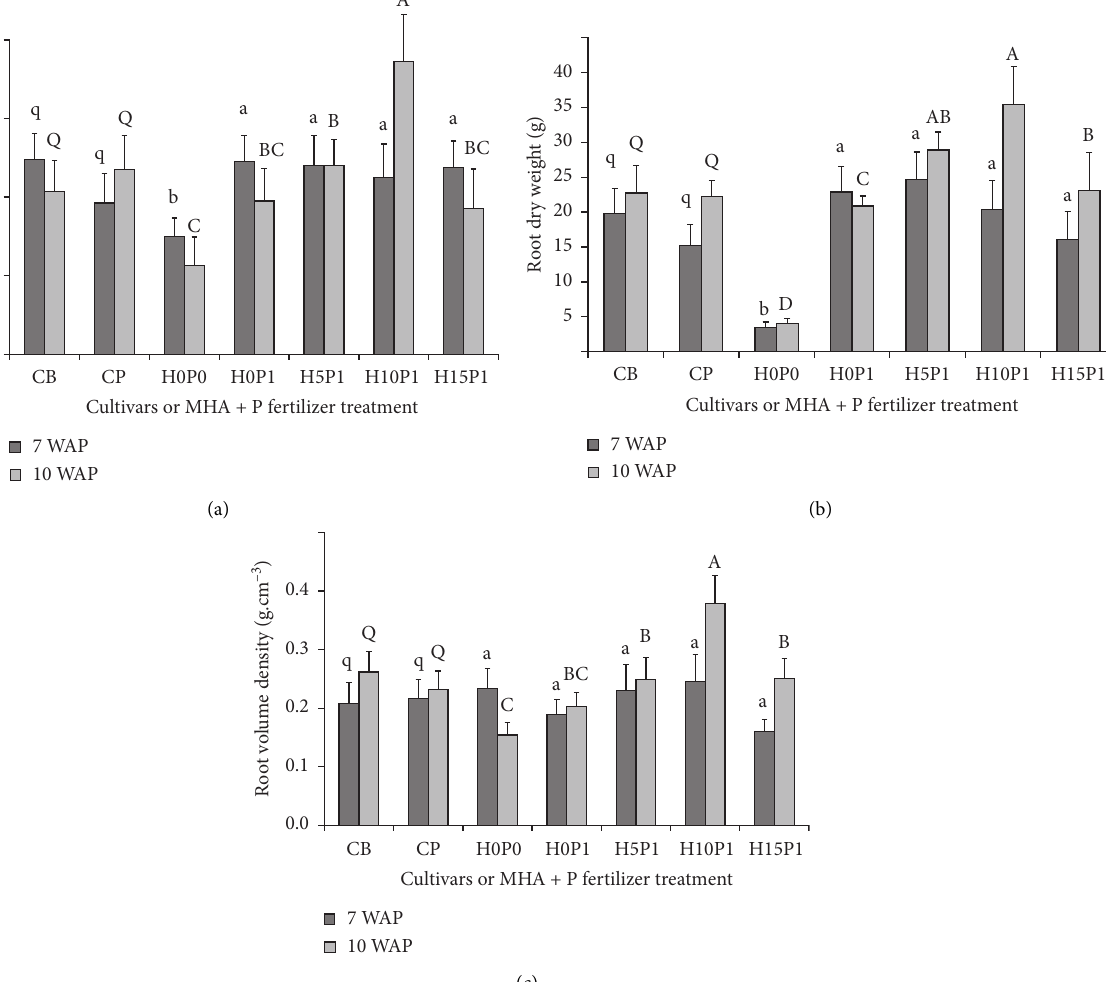
Figure 1: Root diameter (a), root dry weight (b), and root volume density (c) of corn 7 and 10 weeks after planting (WAP). CB is Bisi 2 hybrid corn, CP is Pioneer 35 hybrid corn. H 0 P 0 is the control, H 0 P 1 is 0 mg kg − 1 composted manure (MHA)+P fertilizer, H 5 P 1 is combined 35mg kg − 1 MHA +P fertilizer, H 10 P 1 is combined 75mg kg − 1 MHA +P fertilizer, and H 15 P 1 is combined 110mg kg − 1 MHA+P fertilizer. The rate of P fertilizer in each P 1 treatment was equivalent to 120mg P 2 O 5 kg − 1 air-dried soil. Values followed by the same lowercase or uppercase letter were not significantly different based on Duncan’s multiple range test at p < 0 . 05. Results presented are the mean+standard error of 3